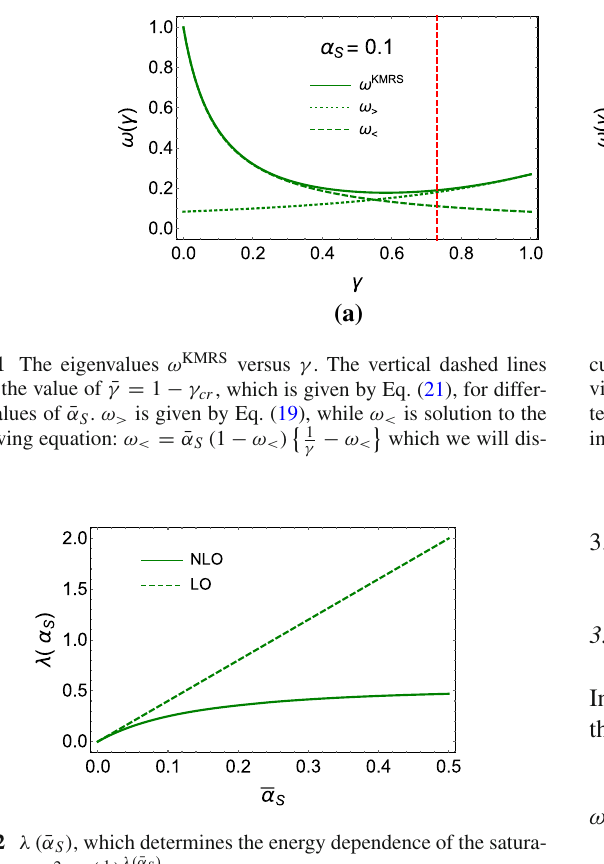
Fig. 2 λ( ¯ α S ) , which determines the energy dependence of the satura- (cid:2) (cid:3) λ( ¯ α 1 S ) , versus ¯ α tion scale Q 2 s ∝ S . It should be stressed that the NLO x corrections to the energy dependence of the saturation momentum give considerable contributions even at rather small values of ¯ α